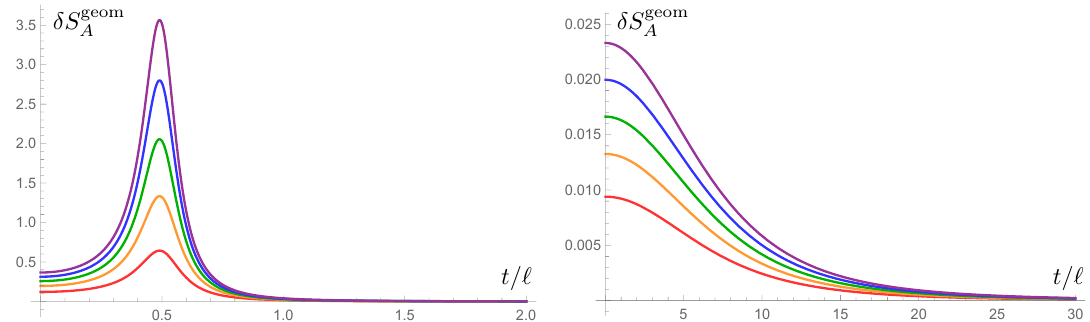
Figure 7 . Time evolution of the geometric correction to entanglement entropy (cid:14)S A for centered in- tervals, with (cid:1) = 3 = 2 ; 2 ; 5 = 2 ; 3 ; 7 = 2 corresponding to the red, orange, green, blue and purple curves, respectively. In the left panel we (cid:12)xed (cid:11)=‘ = 10 (cid:0) 1 , while in the right panel we chose (cid:11)=‘ =